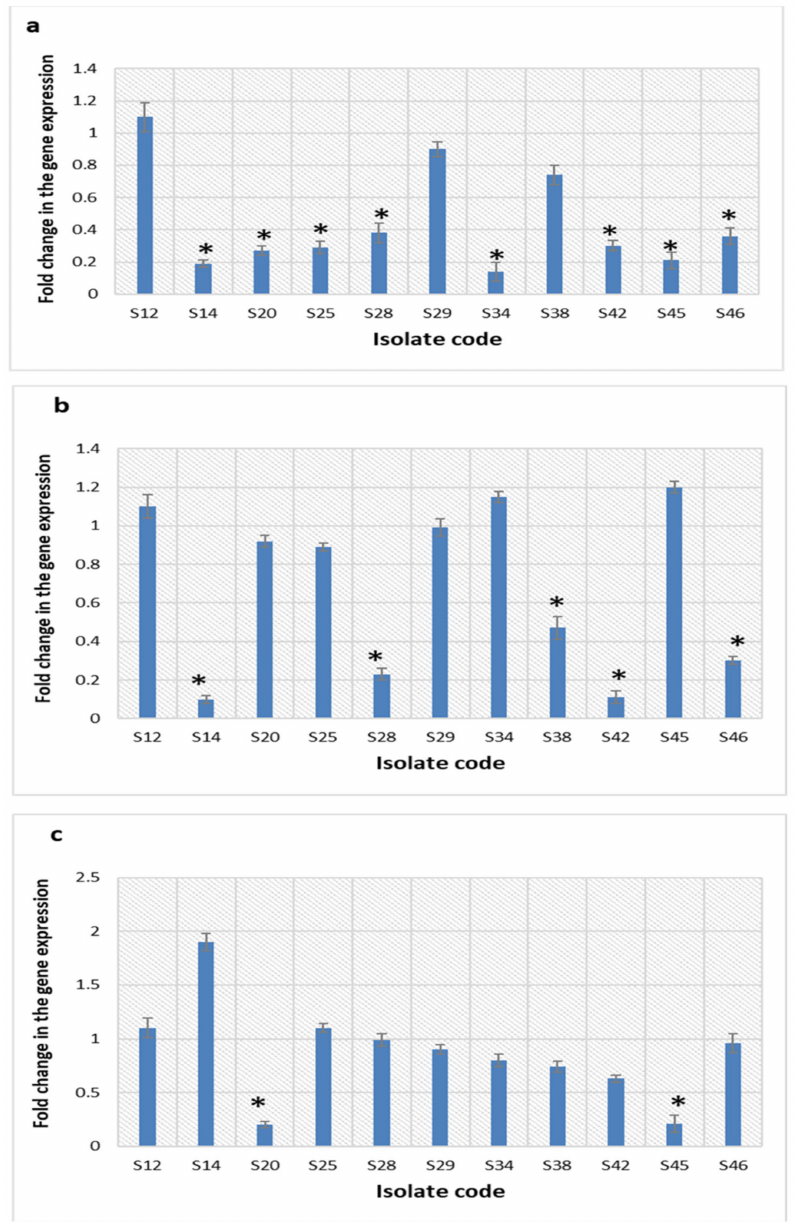
Figure 12. Bar charts showing the transcriptional level fold changes of ( a ) nor A, ( b ) nor B, and ( c ) nor C genes after treatment with the green-synthesized AgNPs. * represents a significant decrease in the fold